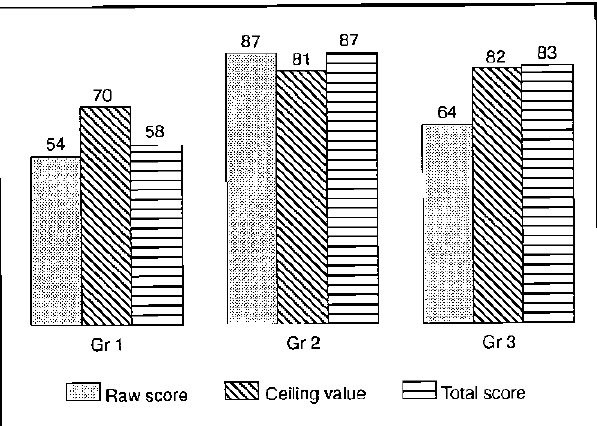
FIGURE 2: Mean raw scores, ceiling values and to-